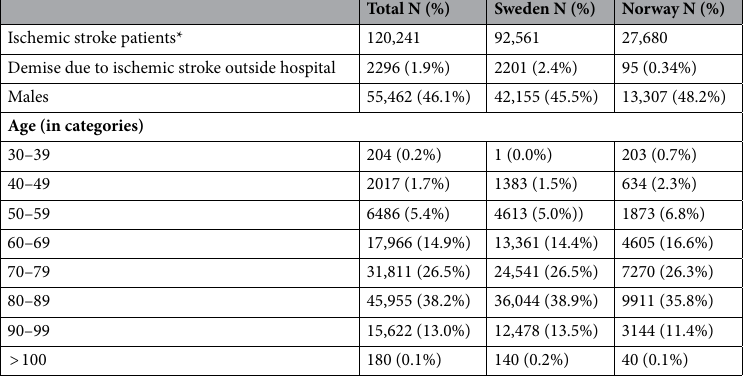
Table 1. Characteristics of the study sample. *The number reflects the patients who were hospitalized or died due to ischemic stroke. In addition, the numbers reflect the patients (N) who dispensed prescribed medicines either in the case-period (1 to 14 days) or control-period (29–42 days) before the date for diagnosis of ischemic stroke (ICD-I63) in Sweden and Norway,